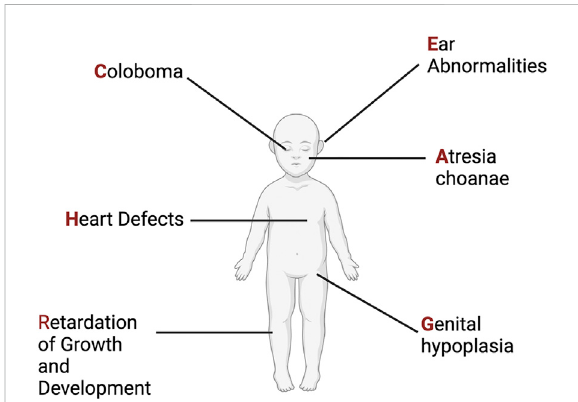
FIGURE 3 CHARGE Syndrome. Original phenotypic description leading to the acronym for CHARGE Syndrome. See text for more details. Figure created with